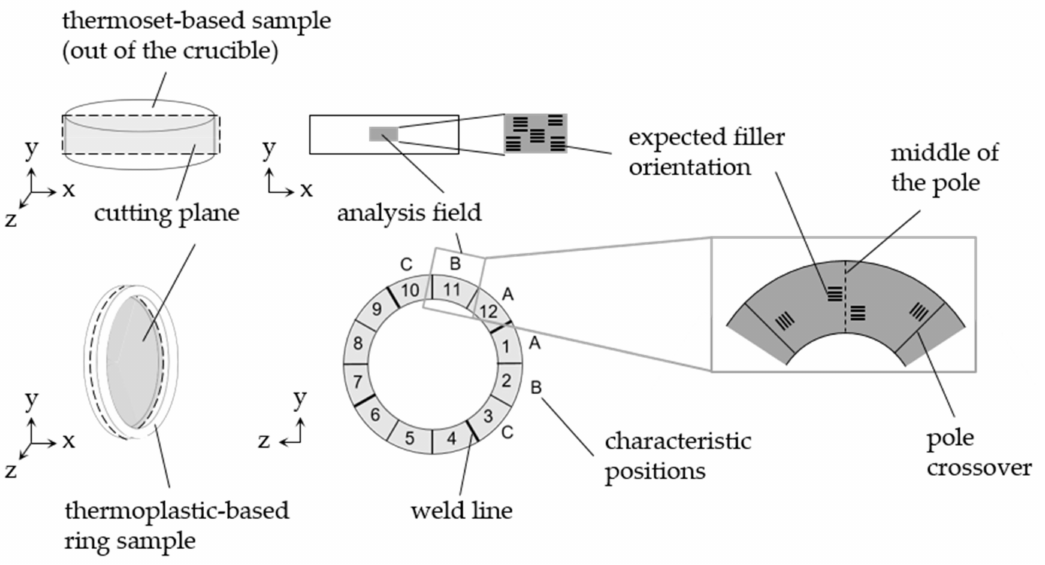
Figure 6. Sample preparation to determine the filler orientation with expected